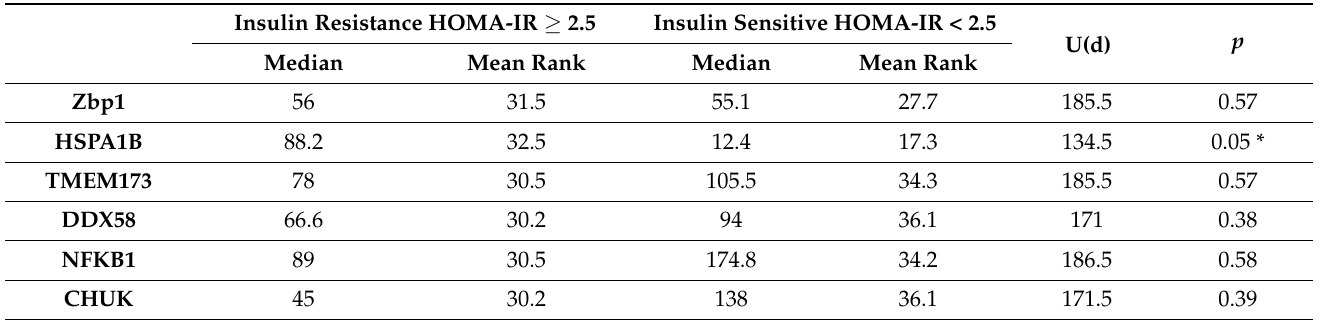
Table 3. Relation between the expression of the 6 mRNAs and the insulin resistance in the T2DM